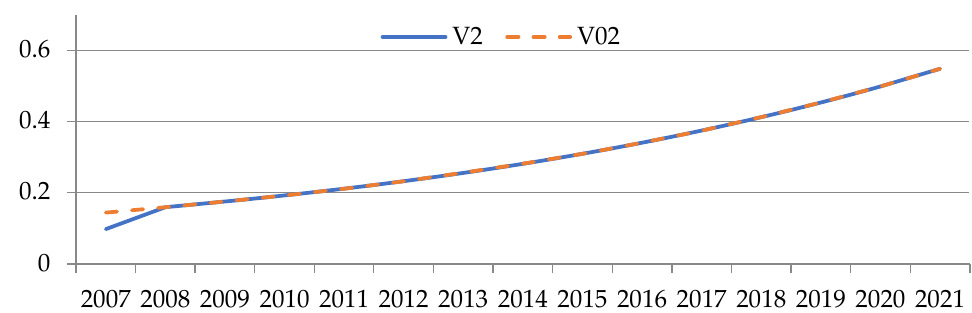
Figure 8. Graphs for tracking the target revenue indicator for industry No. 2 (author’s results).